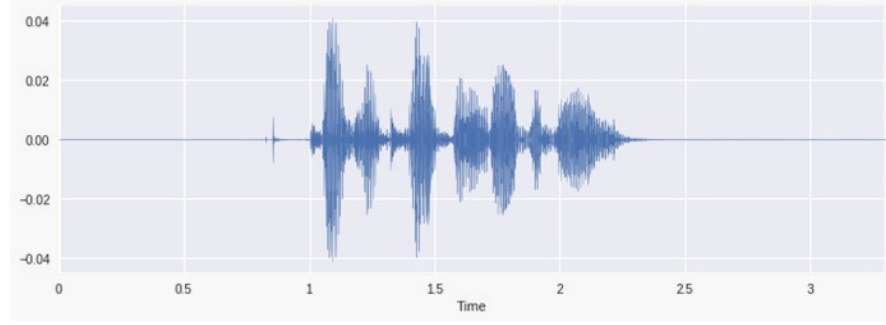
Figure 8. Audio signal.